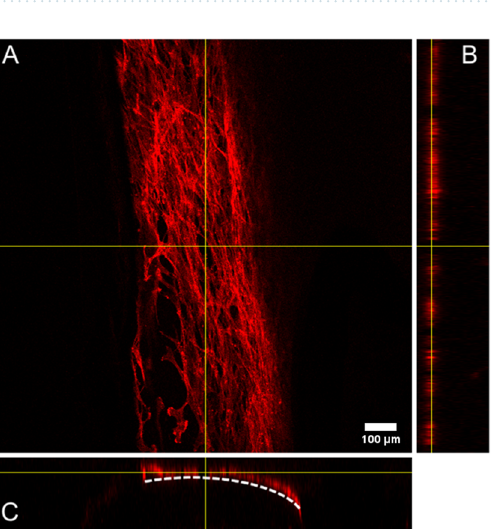
Figure 4. SEM images showing the MSC adhesion on 3D-printed scaffolds after 7, 14 and 21 days of incubation. The arrows point to adherent MSC. Scale bar (for all panels): 50 μm.